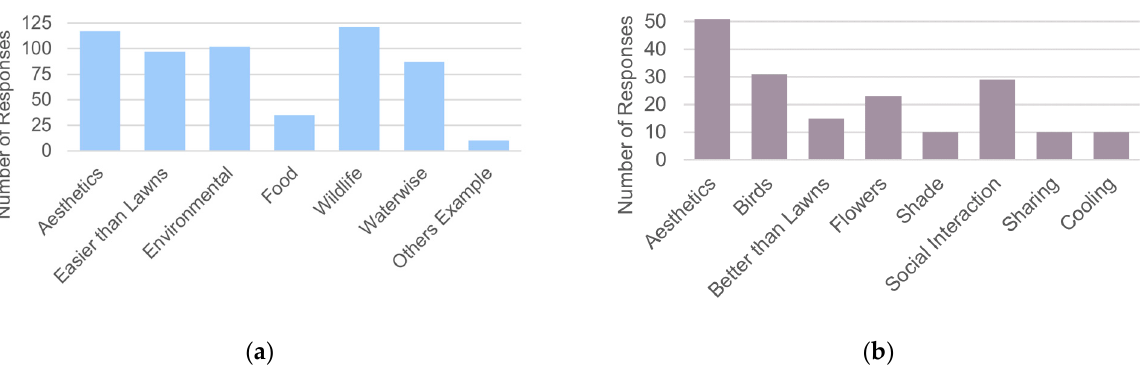
( c ) Figure 8. ( a ) The distribution of age groups of questionnaire respondents; ( b ) the number of years respondents have lived in their home; ( c ) the number of occupants that live within the home of respondents. 5.3.1. Motivations and Perceptions of Verge Gardens The primary motivations for creating a verge garden were to attract wildlife ( n = 121) and for aesthetic reasons ( n = 117), followed by environmental reasons ( n = 102) and easier upkeep than lawns ( n = 97) (Figure 9a). Interestingly, a very low number ( n = 10) of re- spondents claimed to be motivated by other factors. Some common responses for ‘other’ were ‘to reduce weeds’, ‘discourage parking’, and ‘love of gardening’. Respondents were asked to comment on what values their garden provides to the street or local environment. The qualitative responses were categorised into short descrip-